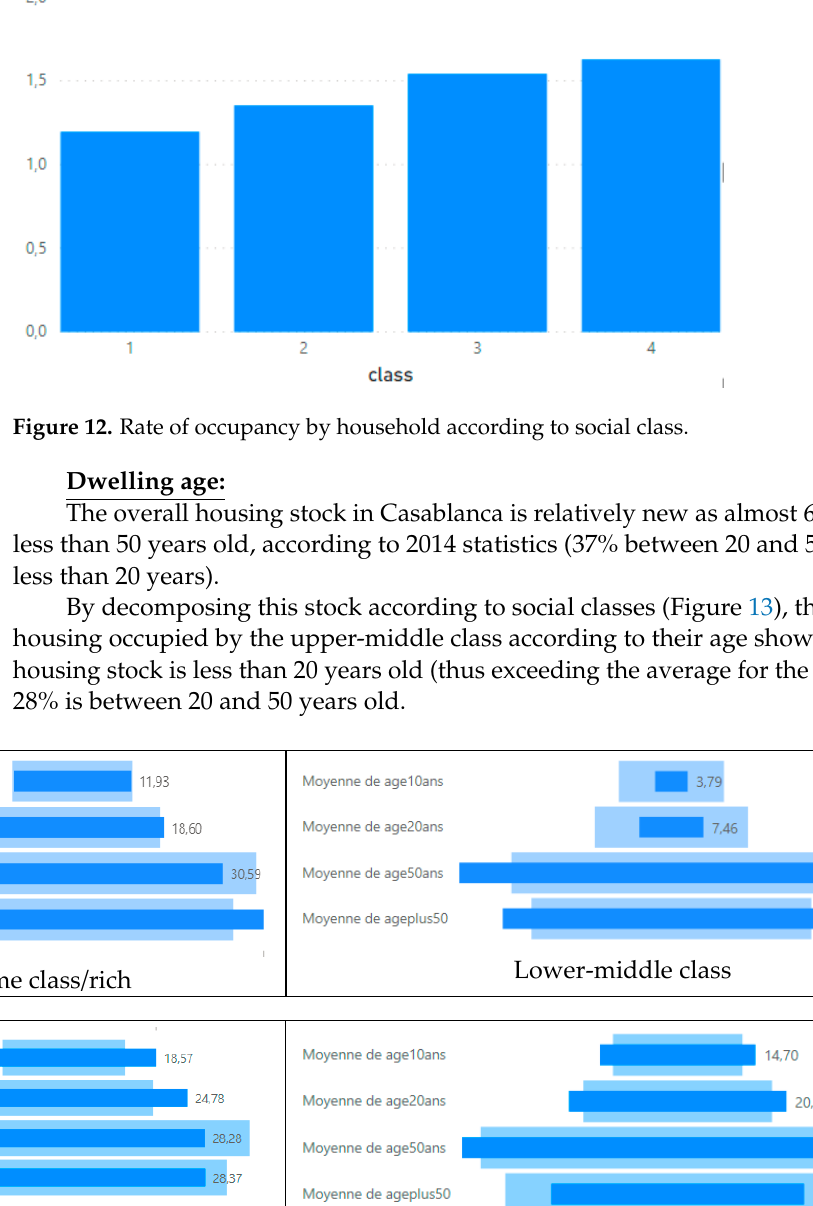
Figure 11. Housing size (1p: one room, 7p: seven rooms).